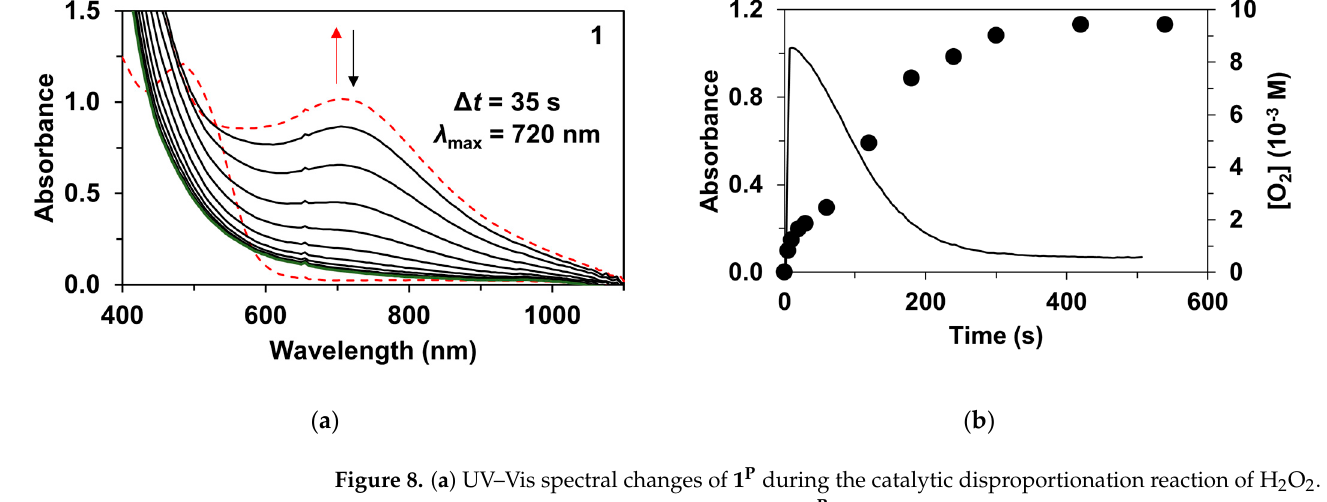
Figure 8. ( a ) UV–Vis spectral changes of 1 P during the catalytic disproportionation reaction of H 2 O 2 . ( b ) Time course of the formation and decay of 1 P during the catalytic disproportionation reaction of H 2 O 2 and the parallel formation of dioxygen monitored by UV–Vis spectroscopy at 720 nm and by volumetrically determined amounts of evolved dioxygen. [ 1 ] 0 = 1.0 × 10 − 3 M, [H 2 O 2 ] 0 = 0.3 M, T = 298 K in MeCN.